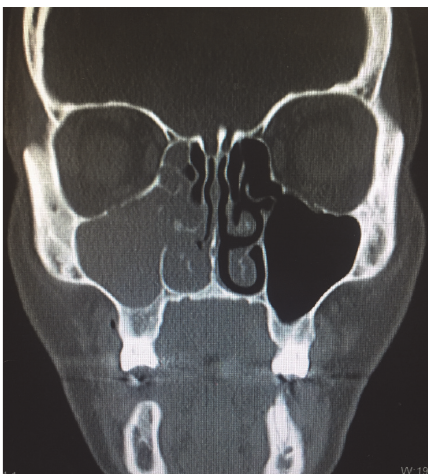
Figure 1: A coronal CT image demonstrating complete opacifica- tion of the right maxillary sinus with soft tissue extending through the ostiomeatal complex and into the right nasal cavity.